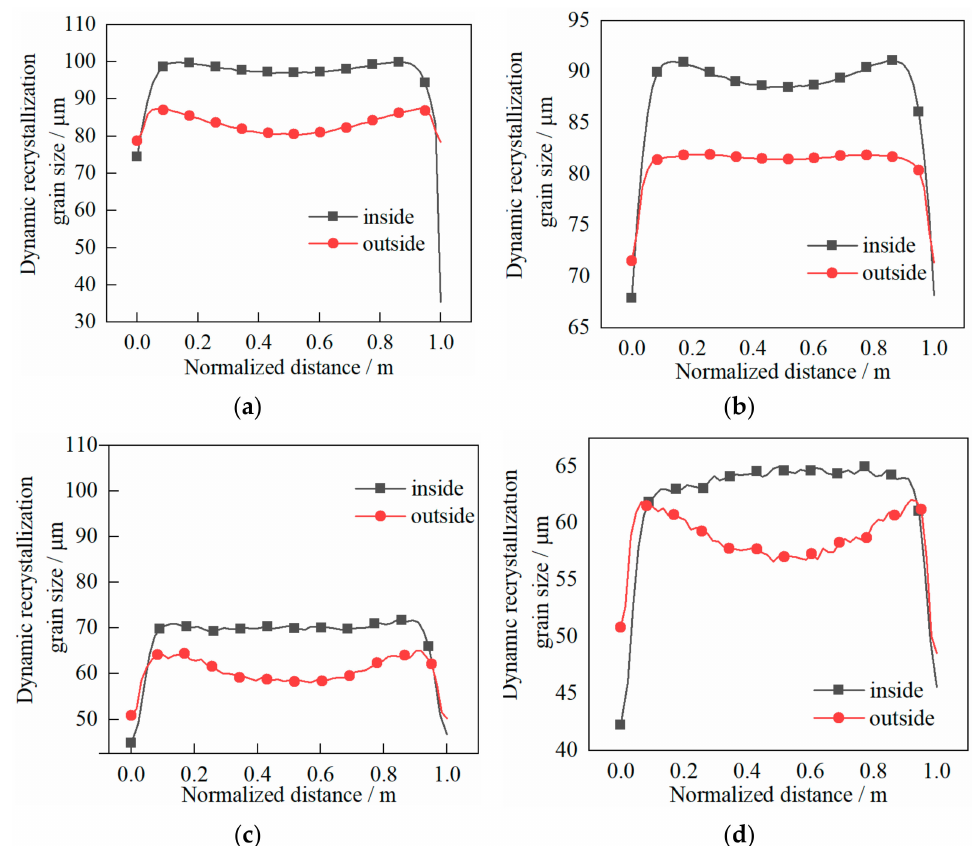
Figure 15. Evolution characteristics of recrystallization grain sizes in two passes of rolling: ( a ) first pass rolling, without shear effect; ( b ) first pass rolling, with shear effect; ( c ) second pass rolling, without shear effect; ( d ) second pass rolling, with shear